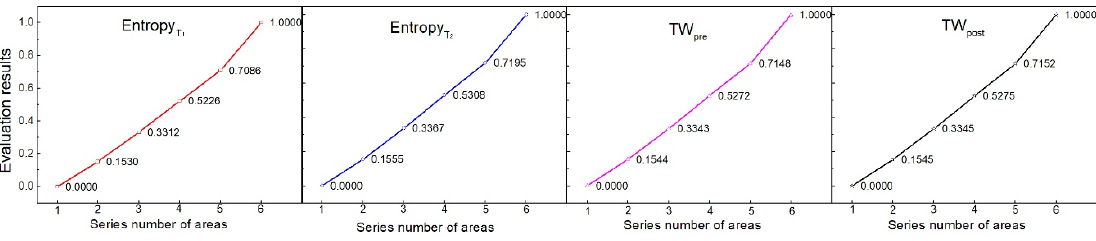
Figure 2. The UUSR evaluation results using di ff erent weighting methods.